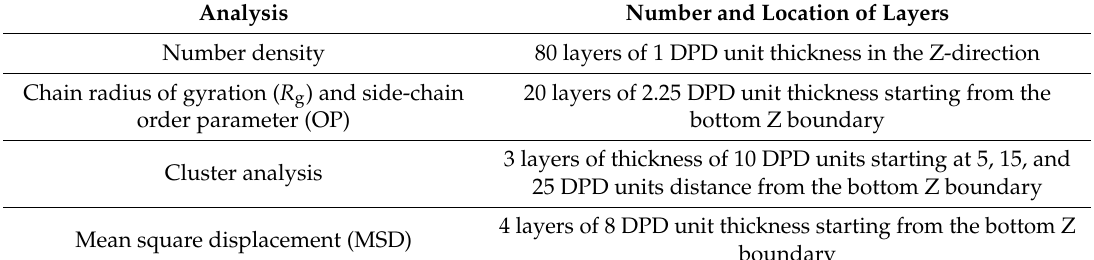
Table 2. Number and location of layers for different analyses carried out in the study.